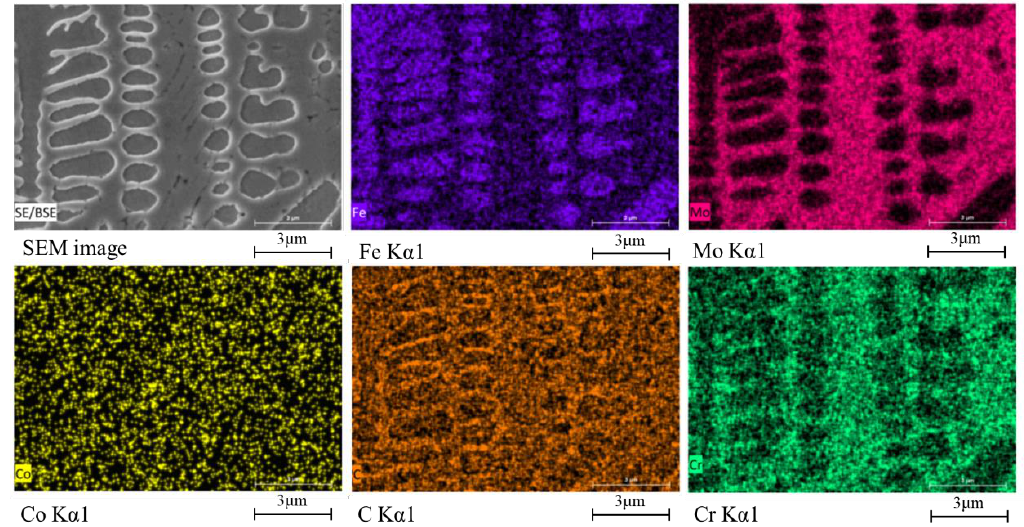
Figure 6. Element distributions of the cladding layer obtained at the scanning speed of 10 mm/s.